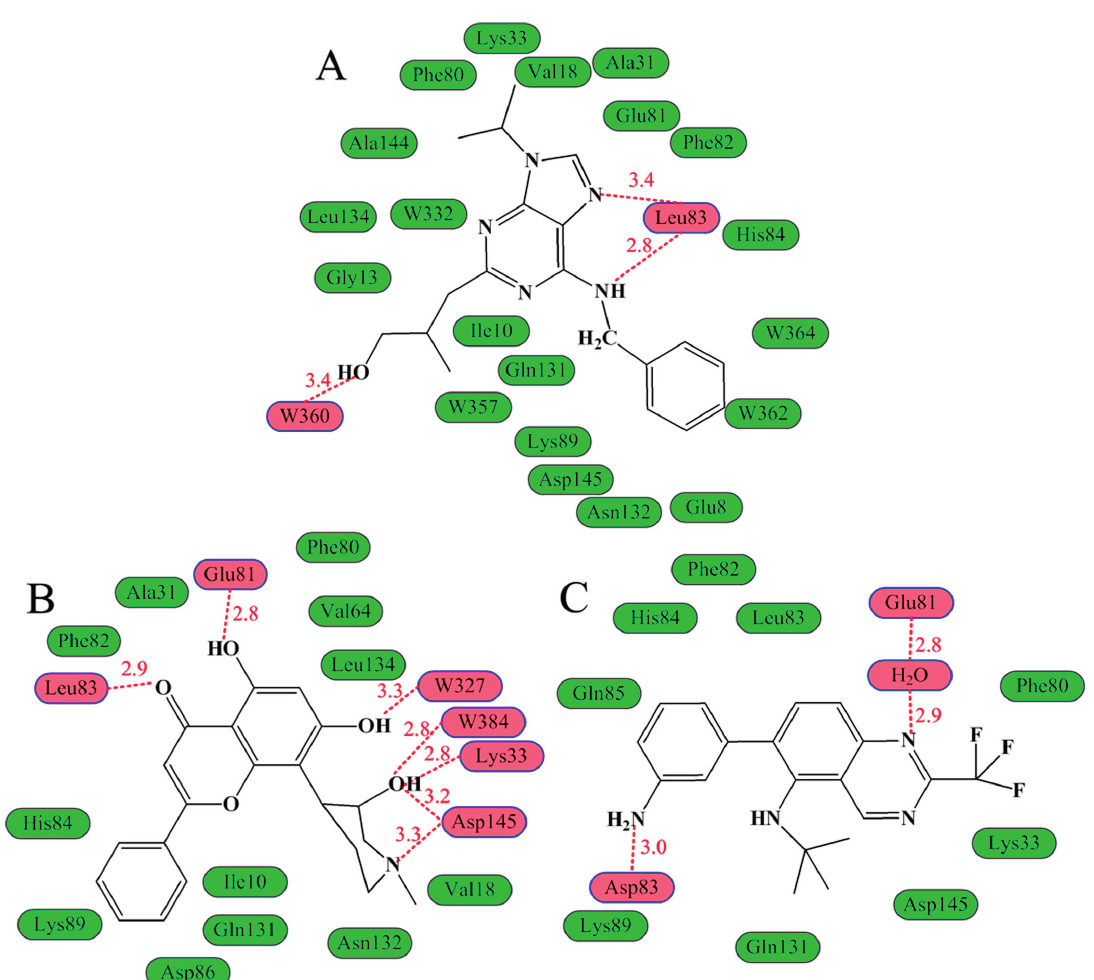
Figure 3. Three binding modes in ATP pocket of CDK2 [80]. The ligands in ( A ); ( B , C ) are roscovitine, flavopiridol and a 4-anilinoquinazoline derivative, respectively. Green nodes represent the residues around the ligands, while pink ones signify those residues and water molecules involved in the H-bond network. Hydrogen bonds are indicated by broken lines with the distance in